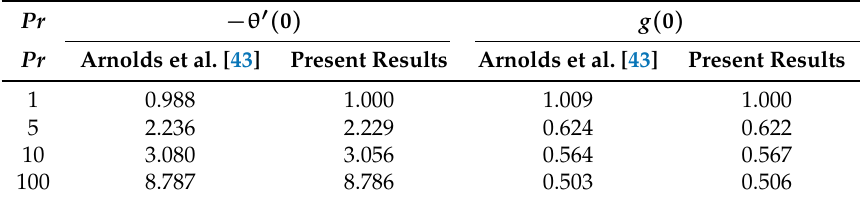
Table 2. Comparison of the numerical results of the heat transfer rate − θ (cid:48) ( 0 ) and the surface temperature g ( 0 ) with the published results of Arnold et al. [43] for the PST- and PHF cases, respectively, for different values of Pr with Ec = 1.0 and K = 0.02.